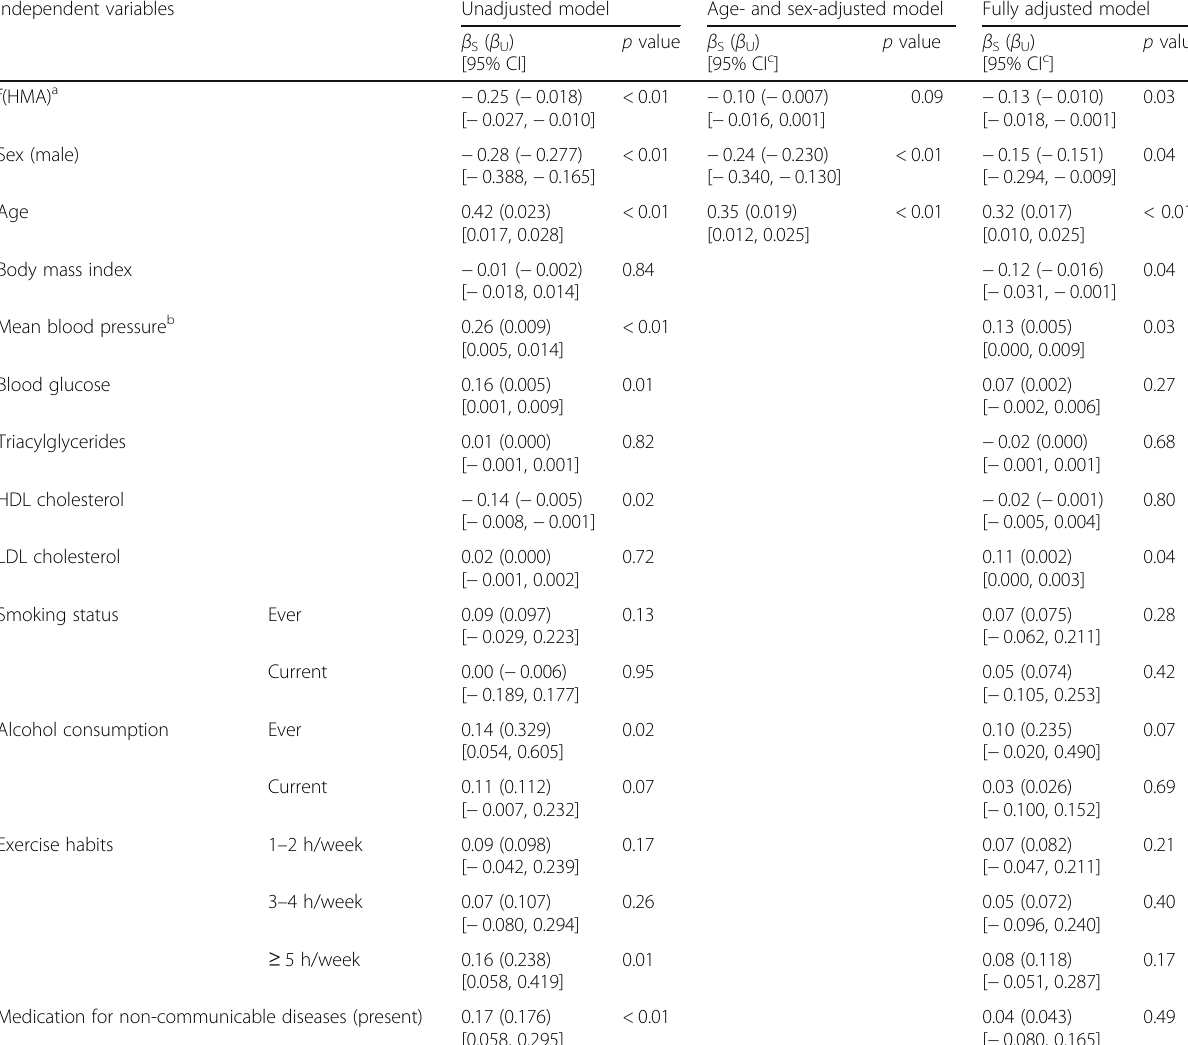
Table 2 Linear regression analysis of the association between selected variables and max IMT Independent